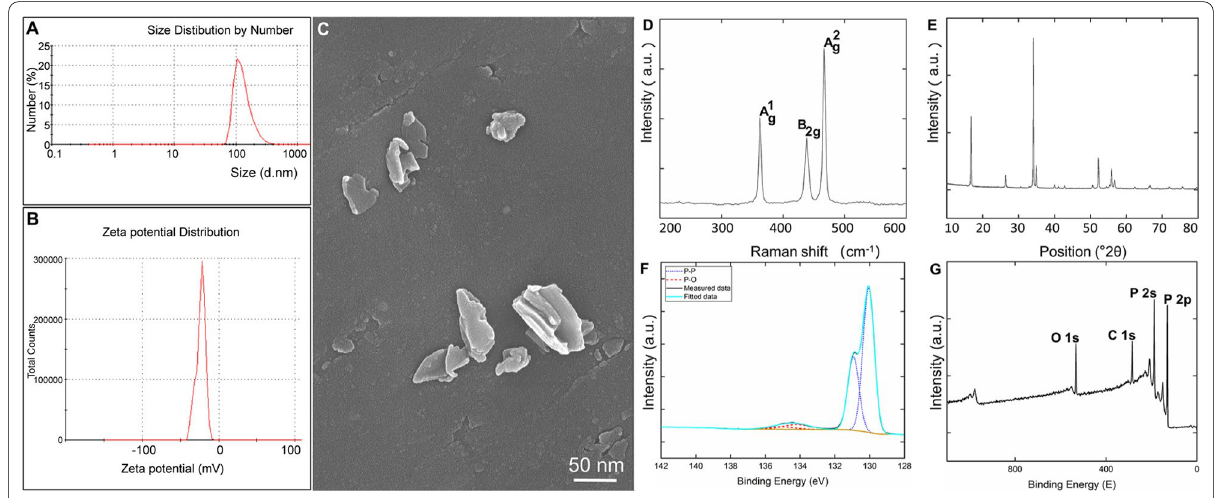
Fig. 1 Characterization of BPs. A Size distribution of black phosphorus nanoparticles (BPs); B zeta potential report of BPs with a zeta potential of 23.7 0.65 mV; C scanning electron microscopy (SEM) images of the BP nanosheets (BPNs). D Raman spectra of BPs; E X-ray diffractogram and − ± F P 2p high-resolution X-ray photoelectron spectroscopy (XPS) spectra of BPs; G XPS spectra of